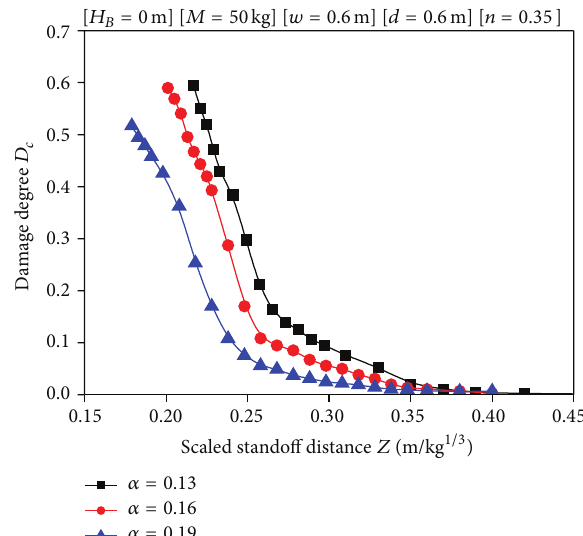
Figure 13: Effects of steel ratio on the damage degree.